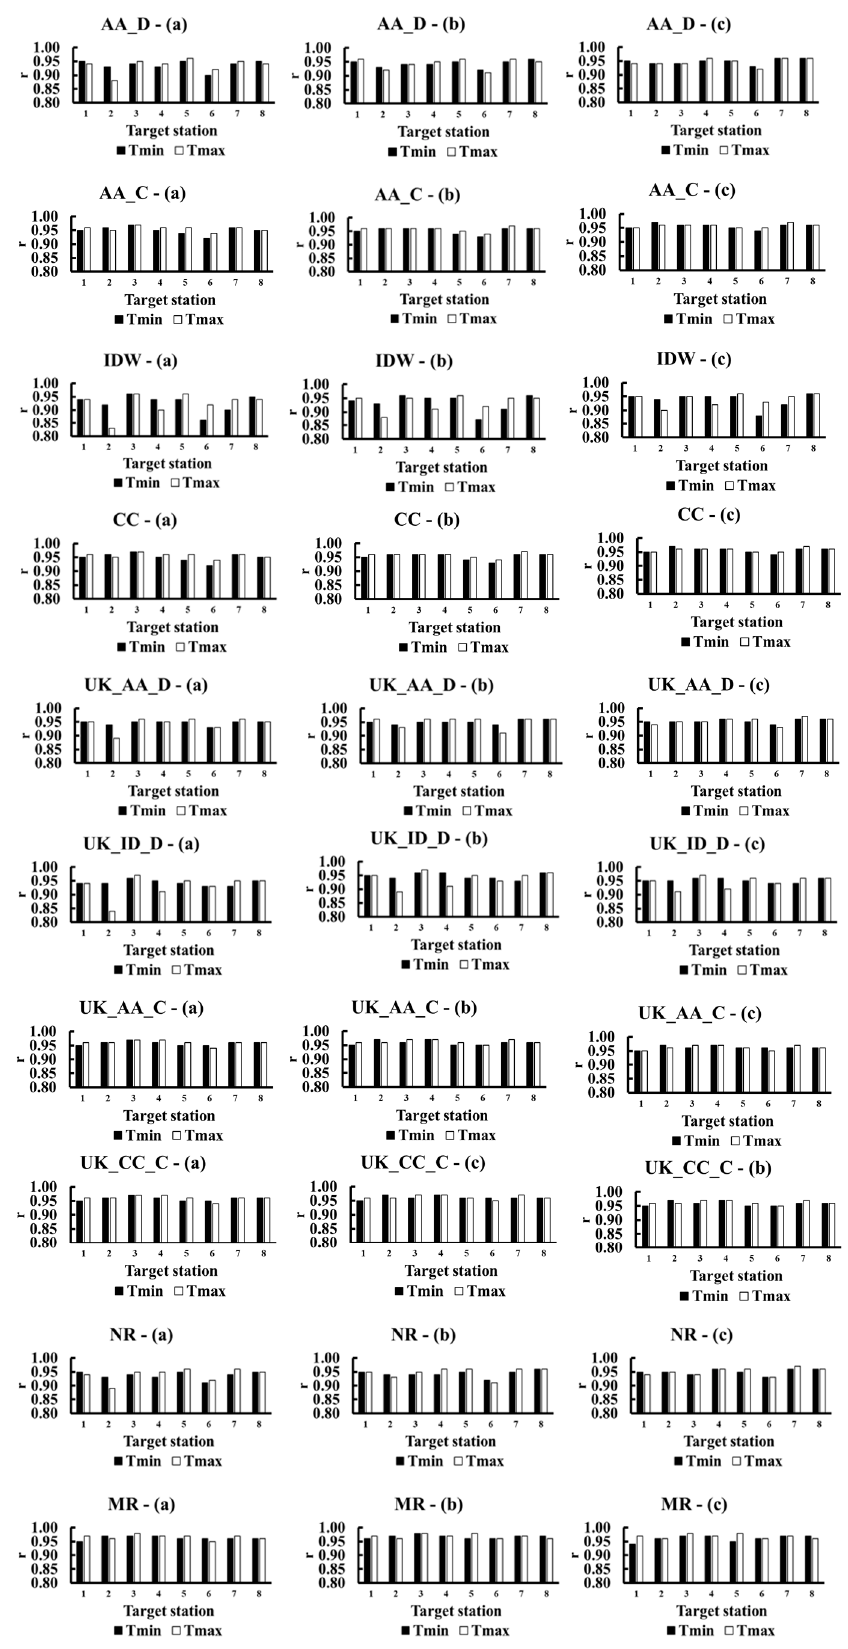
Figure 2. Correlation coefficient (r) for estimating minimum and maximum temperatures for each infilling method at all target stations using ( a ) three target stations, ( b ) 5 target stations and ( c ) 8 target stations.